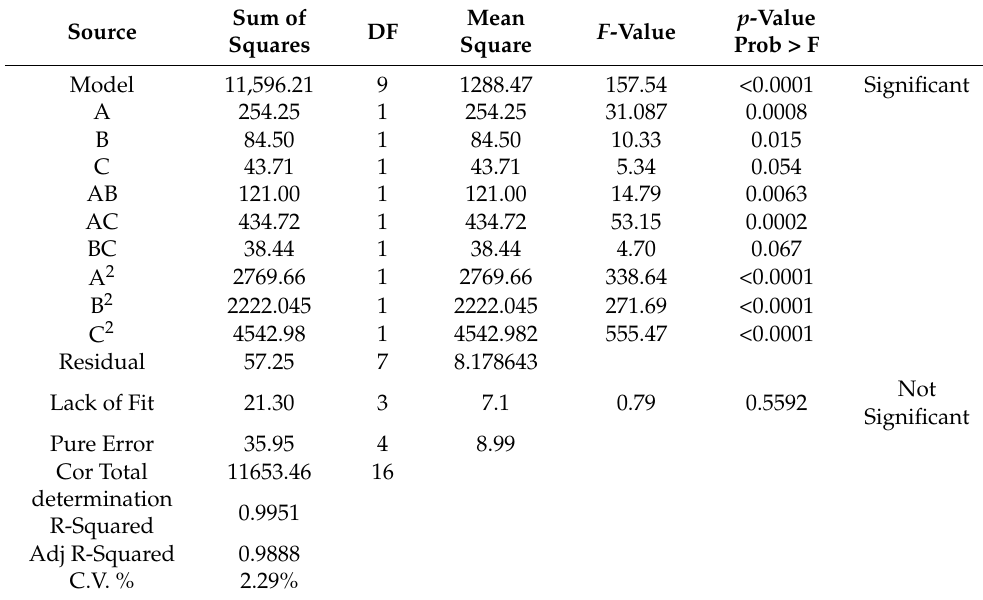
Table 5. ANOVA of the regression model for the emission intensities prediction of N-CQD